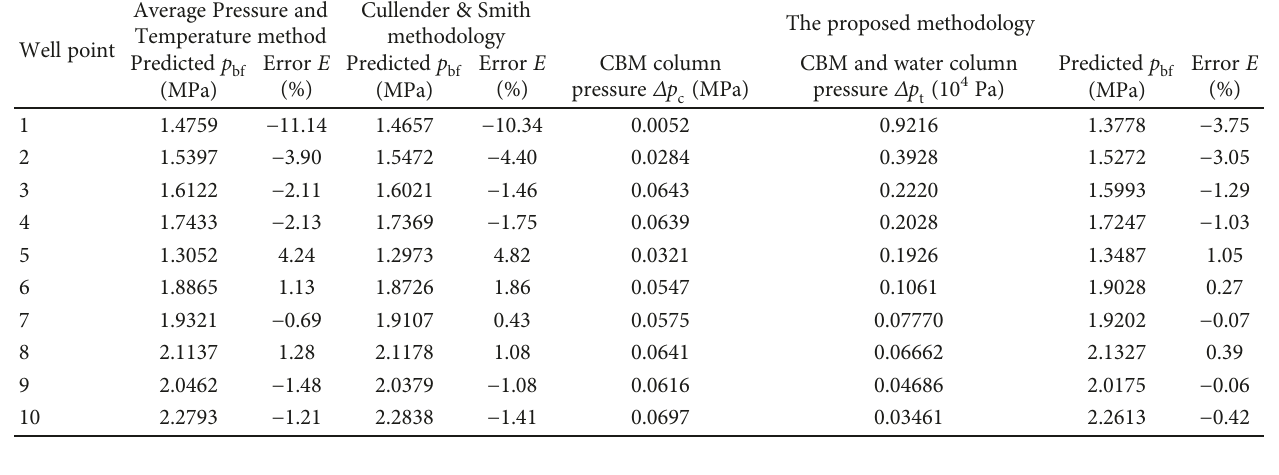
Table 2: Predicted variables of fl owing pressure and error in the approaches due to the relationships developed in two-phase CBM wellbores. Well point